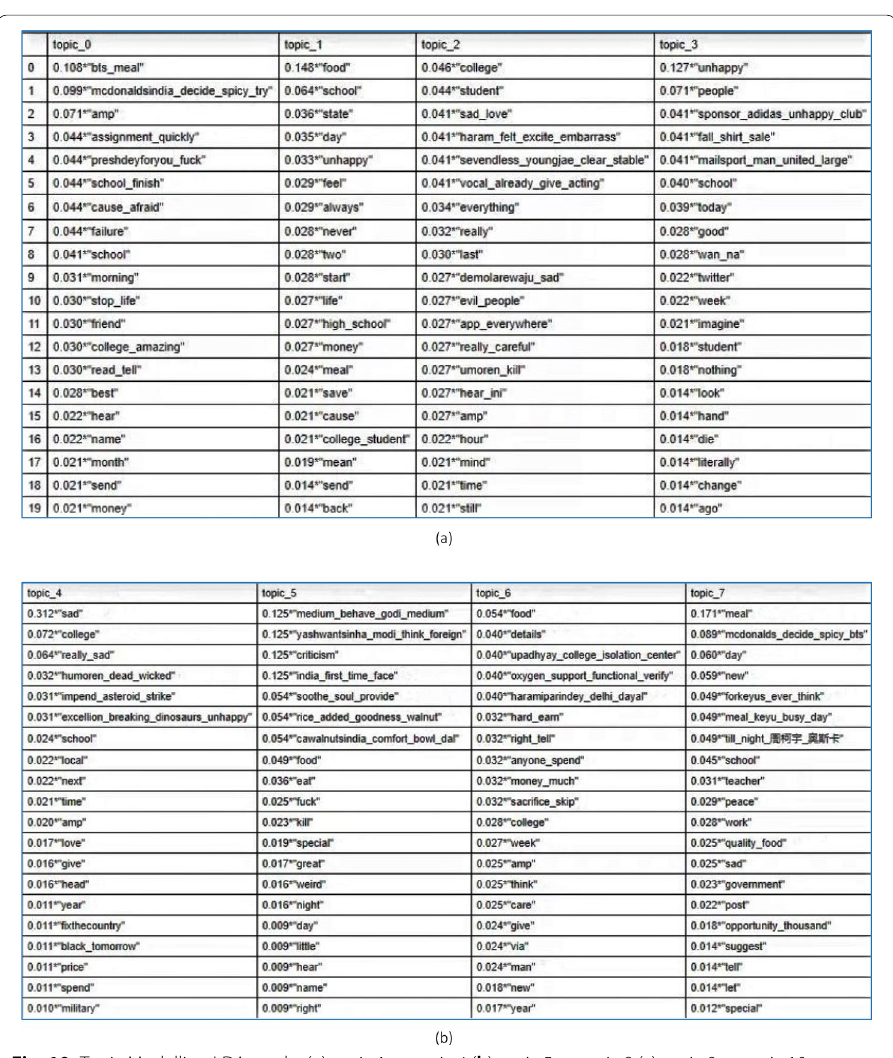
Fig. 10 Topic Modelling LDA results ( a ) topic 1 to topic 4 ( b ) topic 5 to topic 8 ( c ) topic 9 to topic